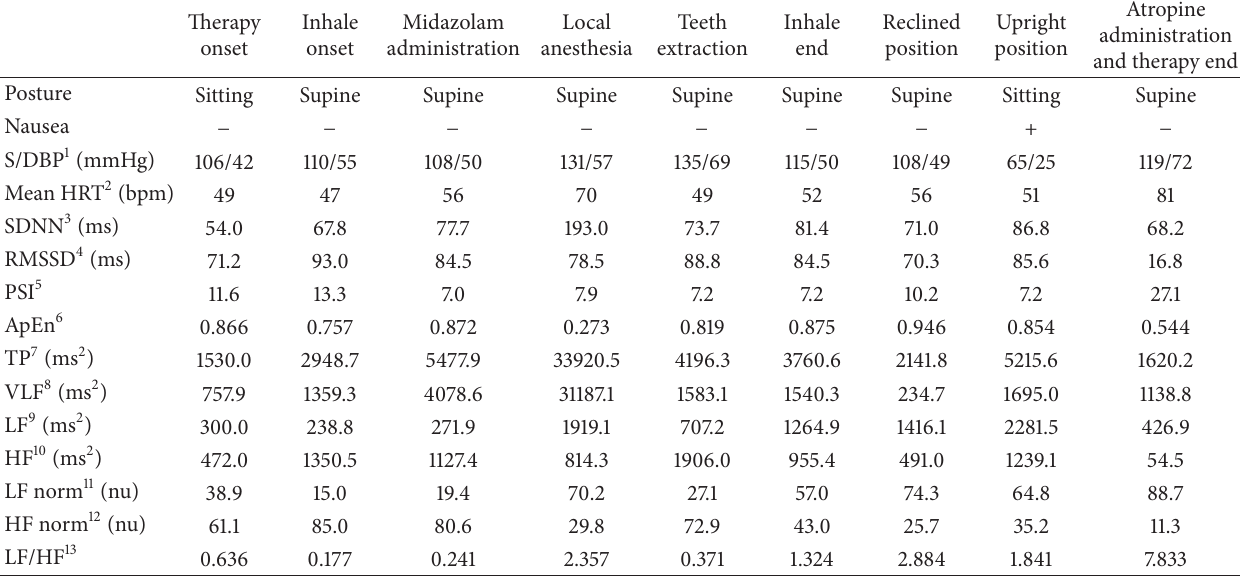
Table 1: Clinical manifestation and scores of frequency-/time-domain HRV variables during dental therapy. Therapy Inhale Midazolam onset onset administration